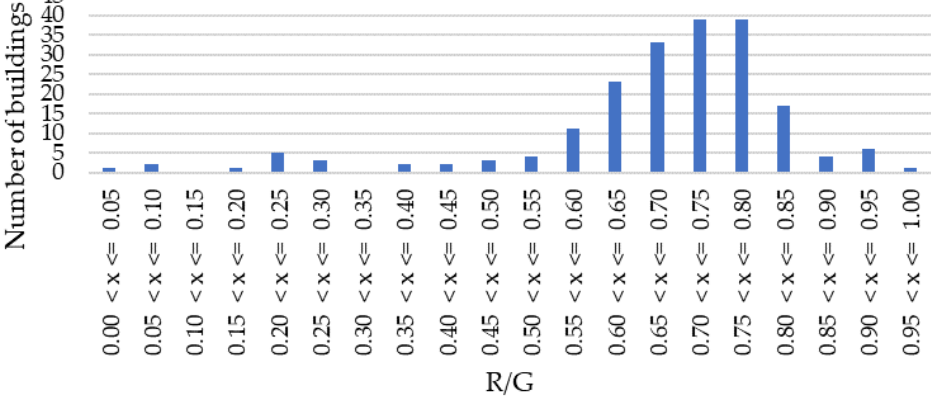
Figure 11. Histogram of R/G.